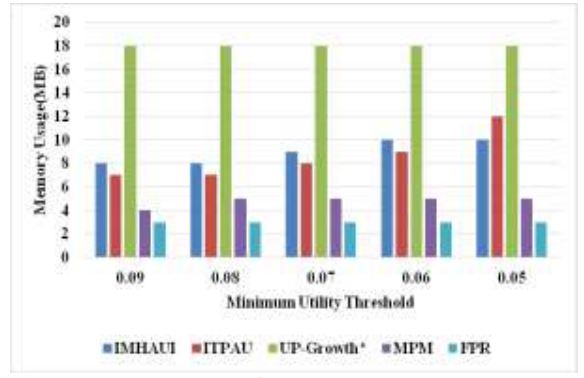
Figure 10. Heart_Cleveland Memory Usage